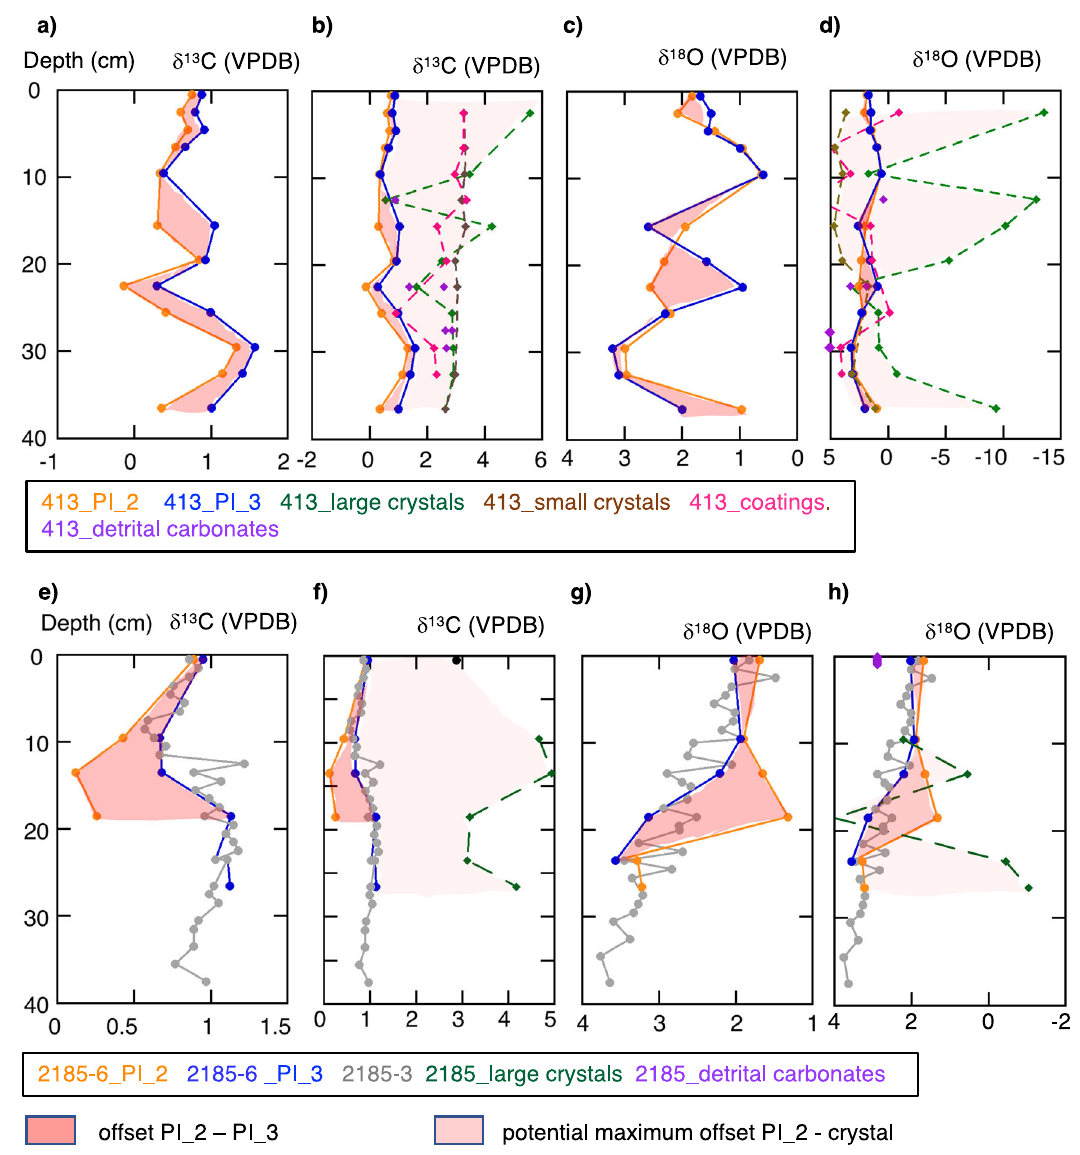
Fig. 5 Carbon and oxygen isotope values in the investigated cores. a – d PS72/413-3. a , b Carbon isotope values of N. pachyderma ( a ), and incl. crystals, envelopes and detrital carbonate ( b ). c , d Oxygen isotope values of N. pachyderma ( c ), and incl. crystals, envelope and detrital carbonate ( d ). e – h PS2185- 6/3. e , f Carbon isotope values of N. pachyderma this study and Nørgaard-Pedersen 4 ( e ), and incl. crystals ( f ). g , h Oxygen isotope values of N. pachyderma this study and Nørgaard-Pedersen 4 ( g ), and incl. crystals ( h